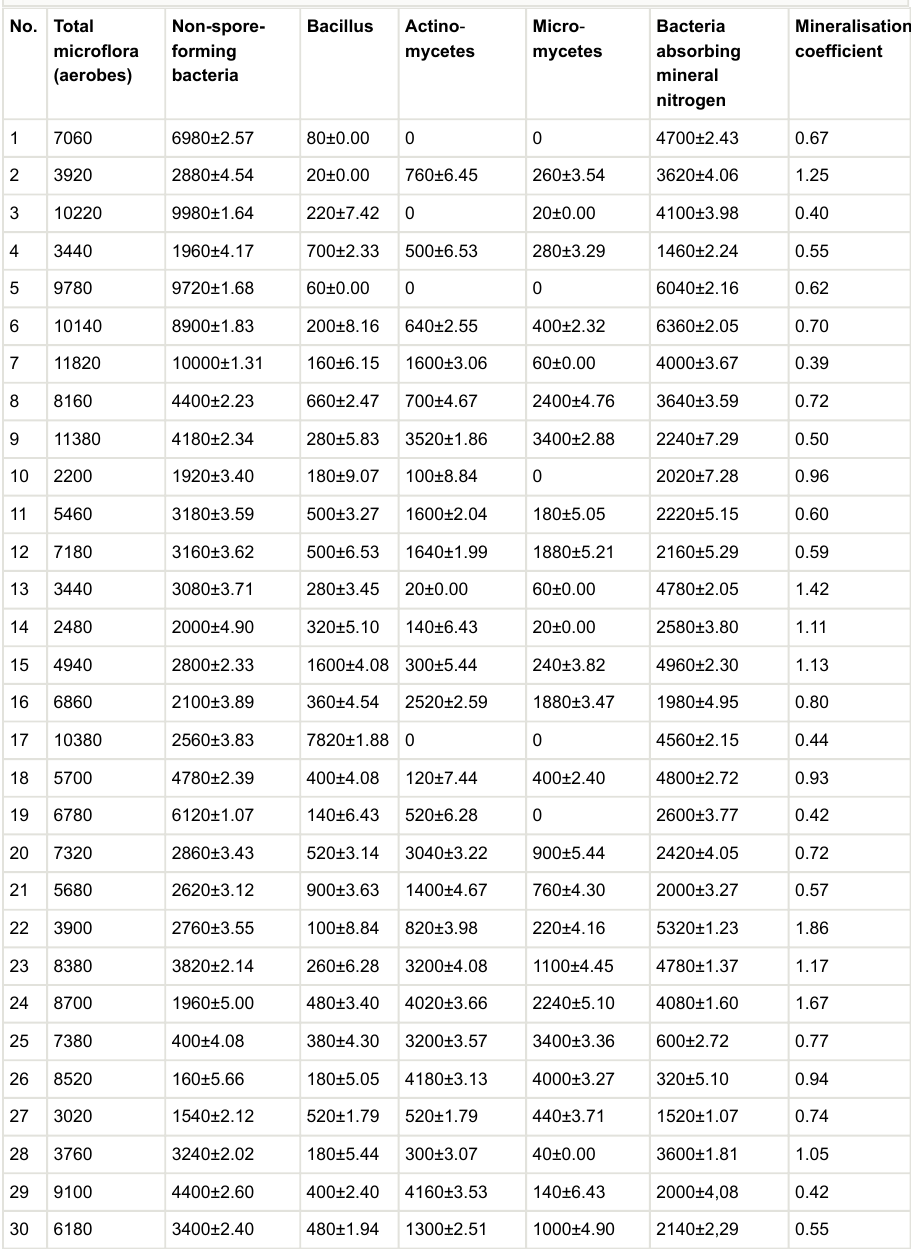
Table 2. Quantity and qualitative composition of aerobic soil microorganisms (CFU x 10/g abs. dry soil);